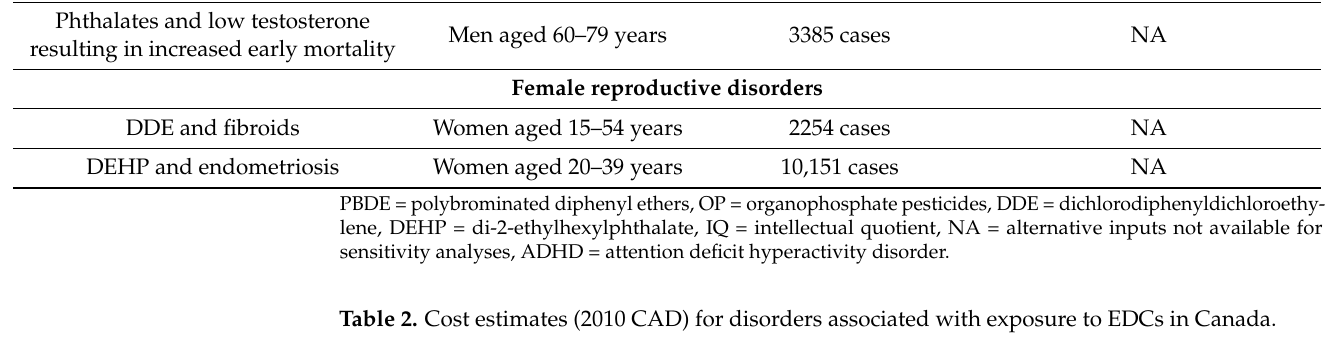
Table 2. Cost estimates (2010 CAD) for disorders associated with exposure to EDCs in